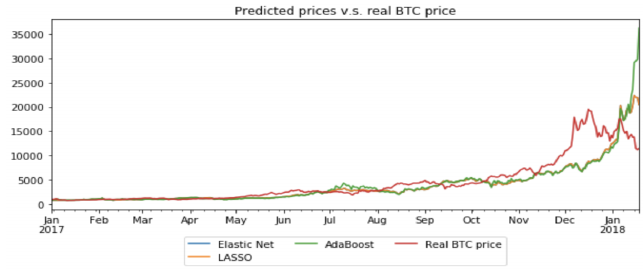
Figure 12: Predicted price vs. Real BTC price (predicting 30-day returns) Notes: This figure shows results from Jan 2017 to Feb 2018 for the top 3 algorithms (in terms of